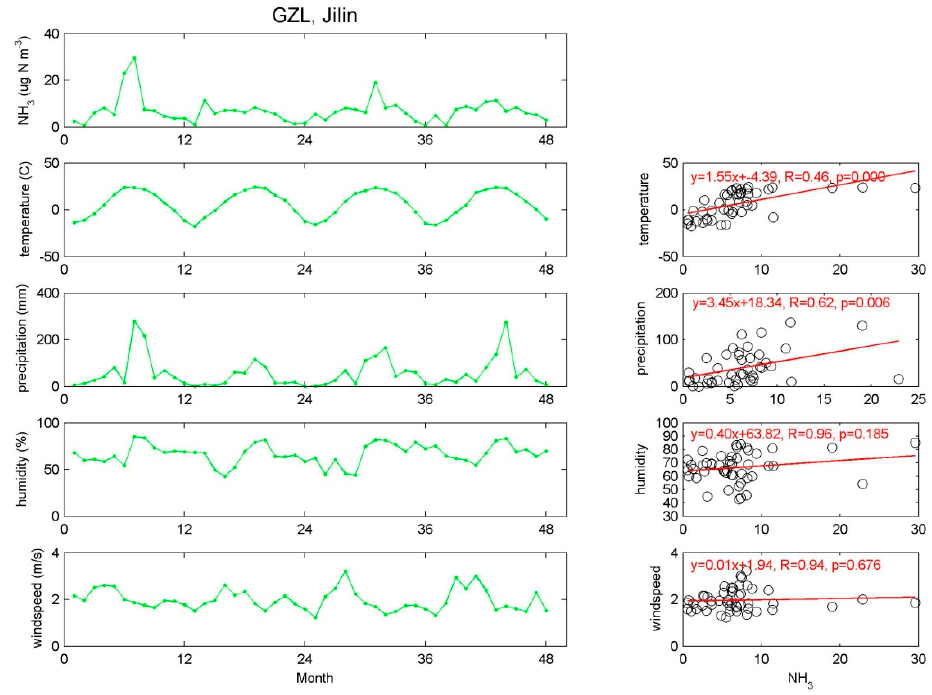
Figure A4. The seasonal variations of ground NH 3 concentrations (µg N m − 3 ), temperature (°C), precipitation (mm), humidity (%), and wind speed (m/s) at GZL from January 2010 to December 2013 (0–12, 2010; 13–24, 2011; 25–36, 2012; 37–48, 2013).